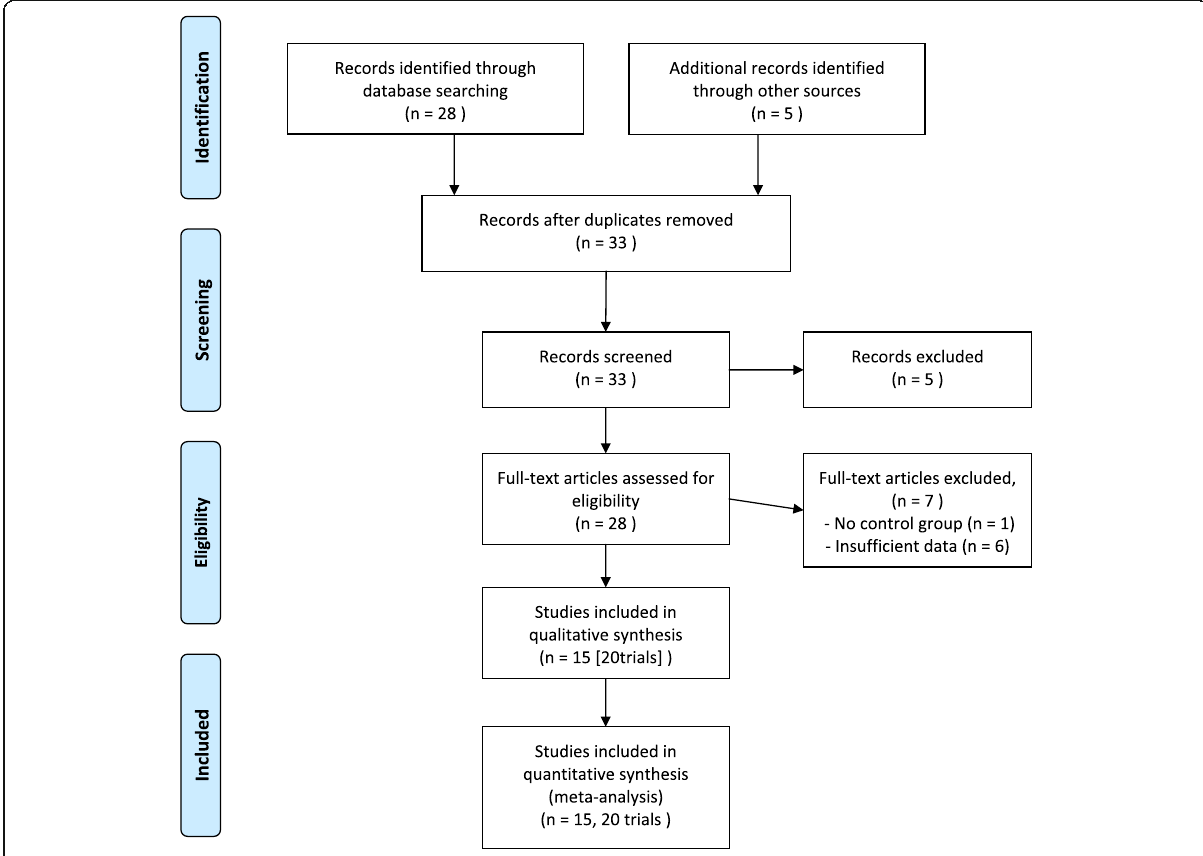
Fig. 1 Flow chart of the study selection process for the present